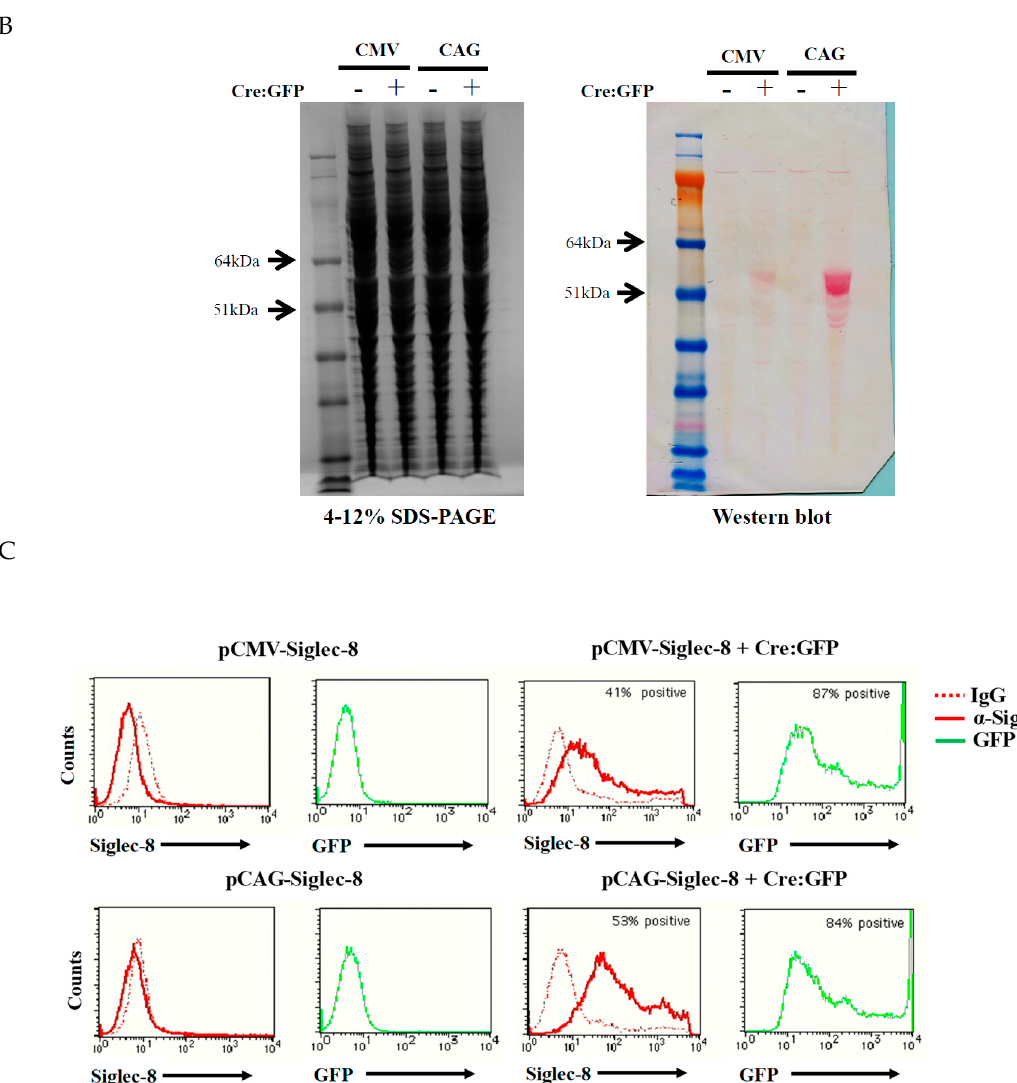
Figure 2. In vitro testing of conditional expression of human Siglec-8 in transfected HEK 293T cells. ( A ) ROSA26-CMV-Siglec-8 and ROSA26-CAG-Siglec-8 conditional knock-in targeting constructs were transfected with or without the Cre:GFP plasmid into confluent HEK 293T cells. Twenty-four hours after transfection, cells were examined and photographed under fluorescent microscope. The presence of GFP indicated successful transfection and expression of the Cre:GFP plasmid; ( B ) total cellular proteins from each sample were harvested and subjected to 4–12% gradient SDS-PAGE and analyzed by western blot using anti-Siglec-8 antibody (Sheep, primary). Anti-sheep IgG conjugated with AP (secondary) was used to visualize the positive bands; ( C ) transfected HEK 293T cells were analyzed by flow cytometry using anti-Siglec-8 antibody. Only cells transfected with ROSA26-CAG-Siglec-8 or ROSA26-CMV-Siglec-8 construct plus the Cre:GFP plasmid showed Siglec-8 expression.